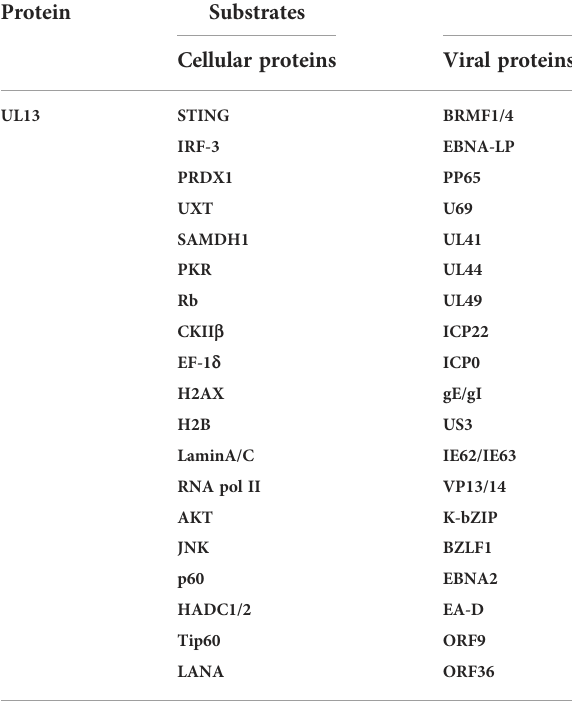
UL13: represents the conserved herpesvirus protein kinase of all herpesviruses, such as EBV BGLF4 and KSHV ORF36. pUL13, dependent or independent of its kinase activity, regulates Cellular and Viral proteins that affect innate immunity and the cell cycle to promote viral